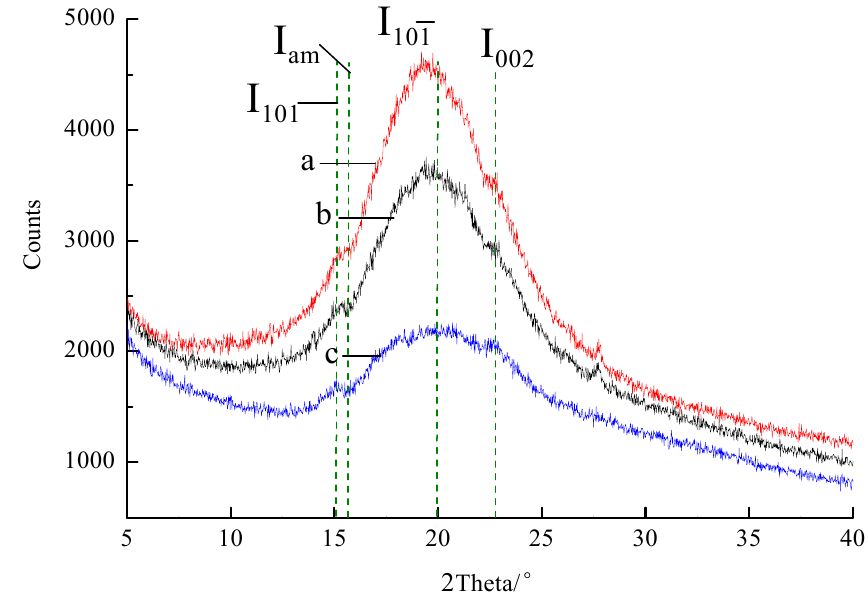
Figure 3. X-ray diffraction (XRD) patterns of Scenedesmus sp. G4 cultures: ( a ) before enzyme hydrolysis; ( b ) hydrolyzed by enzyme mixtures 60 h, pH = 3.5; and ( c ) hydrolyzed by enzyme mixtures 60 h, pH =